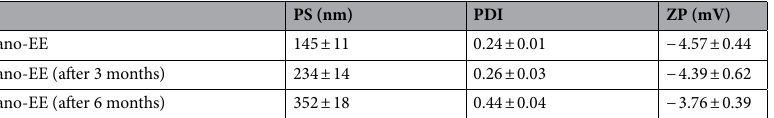
Table 1. Determination of particle size, polydispersity index (PDI), zeta potential (ZP), and stability (after 3 and 6 months) of Nano-EE by dynamic light scattering